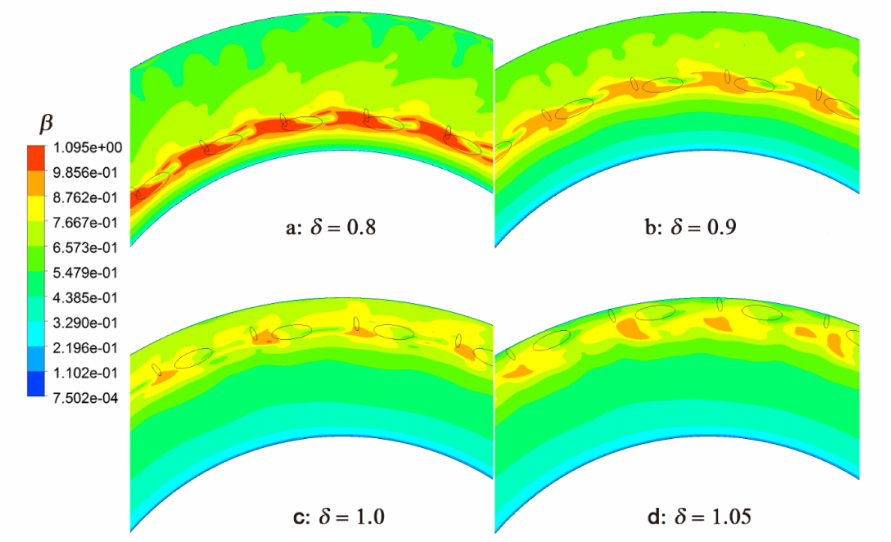
Figure 23. Contour of swirl ratio β at the plane z = 0.5 for different radius ratios of nozzles to holes: ( a ) δ = 0.8, ( b ) δ = 0.9, ( c ) δ = 1.0, ( d ) δ =